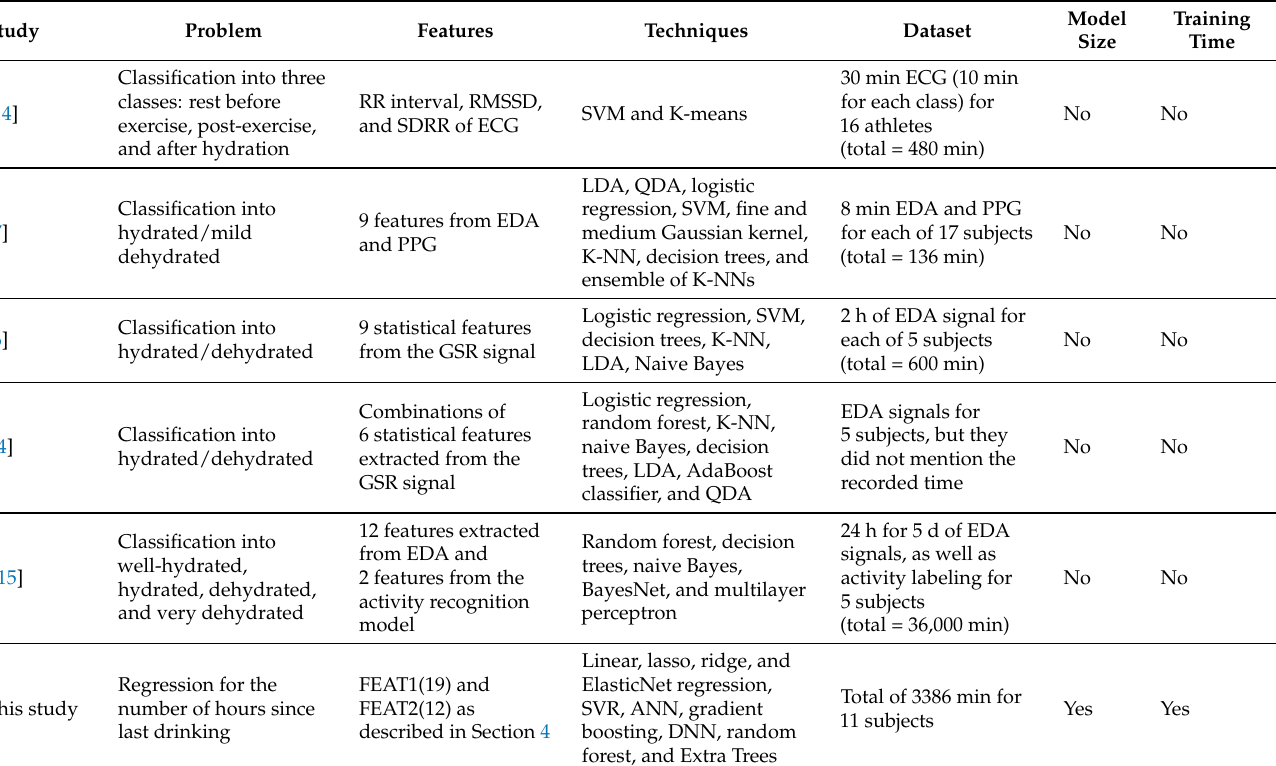
Table 6. Comparison of this study and related studies for dehydration